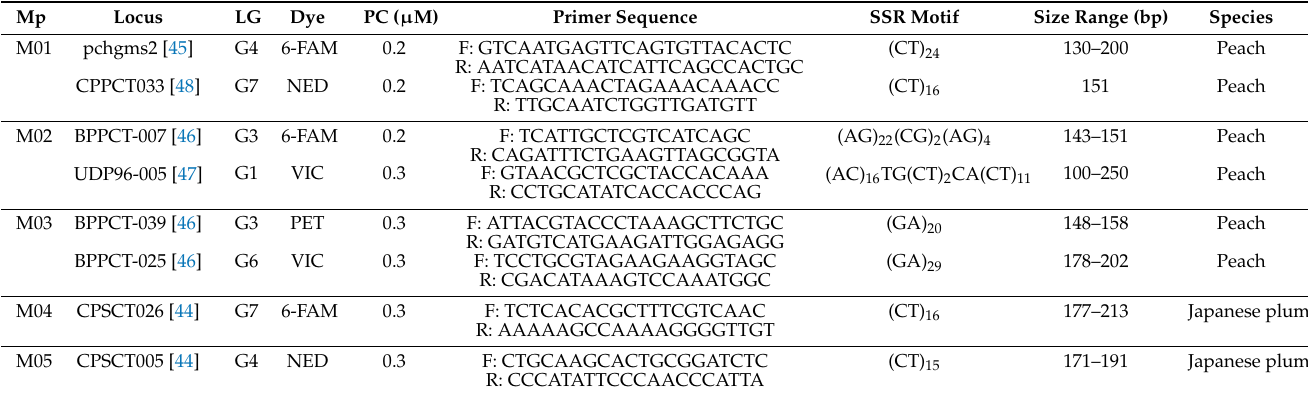
Table 6. Multiplex (Mp) design, SSR loci, linkage group (LG), fluorescent dyes, primer concentration (PC), PCR details and characteristics of the eight SSR markers analyzed in this